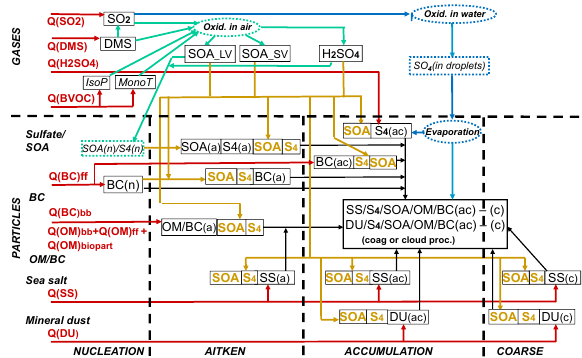
Figure 1. Flow diagram of processes in the aerosol module OsloAero5.3. The source terms to the left, labeled Q(X)y , where X is the constituent name and y is the source type, can be pri- mary emissions or secondary production. The source labels y = bb, ff, or biopart indicate biomass burning, fossil fuel or biofuel com- bustion, and biogenic particle sources. Primary particles are emit- ted (red arrows) as accumulation-mode sulfate (S4(ac)), nucleation- and accumulation-mode black carbon (BC(n), BC(ac)), Aitken- mode BC (BC(a)), internally mixed Aitken-mode organic mat- ter and black carbon (OM / BC(a)), Aitken-, accumulation-, and coarse-mode sea salt (SS(a), SS(ac), SS(c)), and accumulation- and coarse-mode mineral dust (DU(ac), DU(c)). Model-calculated gas-phase components are DMS, SO 2 , isoprene (IsoP), monoter- pene (MonoT), H 2 SO 4 , and gaseous secondary organics (SOAG LV and SOAG SV ) . SOAG LV partly co-nucleates with nucleation-mode sulfate (S4(n), SOA(n), turquoise arrows) and partly condensates (yellow arrows) on existing particle surfaces, while SOAG SV only forms SOA through condensation. Sulfate produced in cloud water droplets (SO4(in droplets), blue arrow) is partly added to S4(ac) and partly to a broad internal mixture of accumulation- and coarse-mode particles coagulated with either mineral dust or sea salt. Black ar- rows represent coagulation that contributes to the latter two particle types. Components in dashed boxes are not explicitly